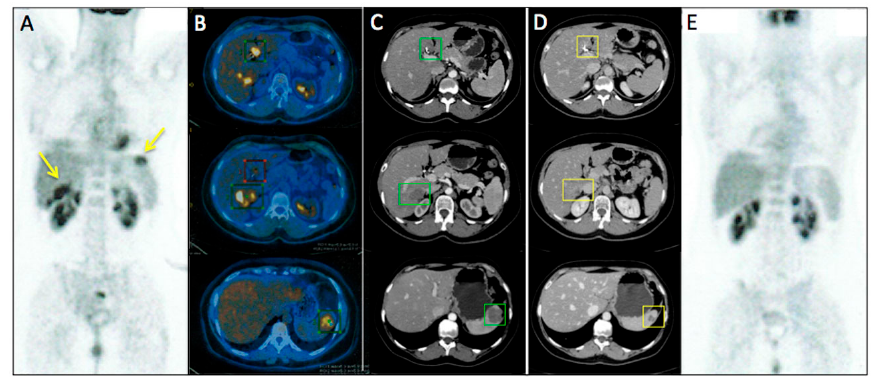
Figure 4. A56-year-old female affected by ovarian cancer with liver and spleen metastasis, already treated with 12 cycles of Bevacizumab-based chemotherapy and 24 hyperthermia sessions on the abdomen, as first-line. Baseline MDCT ( C ) showed metastasis in III and IV segment of the liver (maximum diameter: 77 mm, green squares) and in the upper spleen (maximum diameter: 61 mm, green square). Baseline whole body 18 F-FDG PET/CT ( A ) confirmed liver and spleen involvement by the increased 18 F-FDG uptake (yellow arrows) detectable also on axial fused PET/CT images ( B ) in the same sites (green and red squares). Timepoint-2 MDCT ( D ) evaluation demonstrated significant size decrease of liver and spleen metastasis (yellow squares) with no evidence of 18 F-FDG uptake on whole body PET/CT ( E ). According to mRECIST, patient was classified as CR. Ca125 value evaluated at baseline was 790 UI/mL; while Ca125 value evaluated at timepoint-2 was 12 UI/mL. Side effects reported were limited to asthenia and high blood pressure.